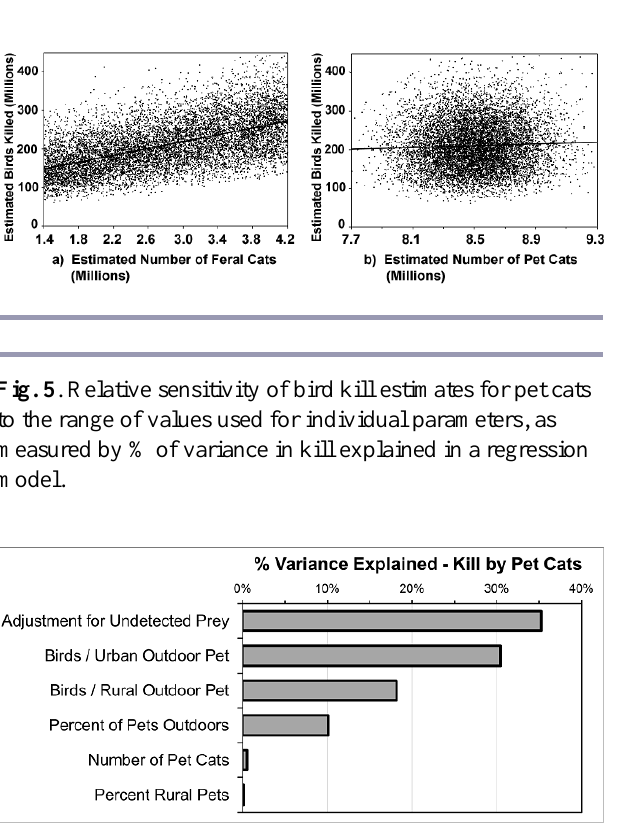
Fig. 4 . Relationship between estimates of total birds killed in Canada vs. values used for: a) number of feral cats (R² = 0.313); and b) number of pet cats (R² = 0.005). Each point represents one of 10,000 iterations, with fitted linear trend line.